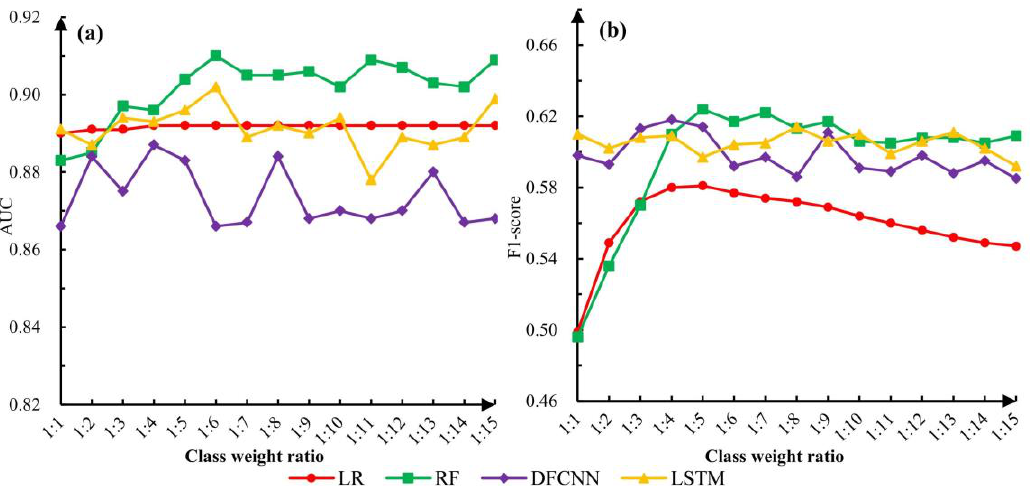
Figure 8. Performances with different class weight ratios: ( a ) AUC performances, ( b ) F1-score per- formances.